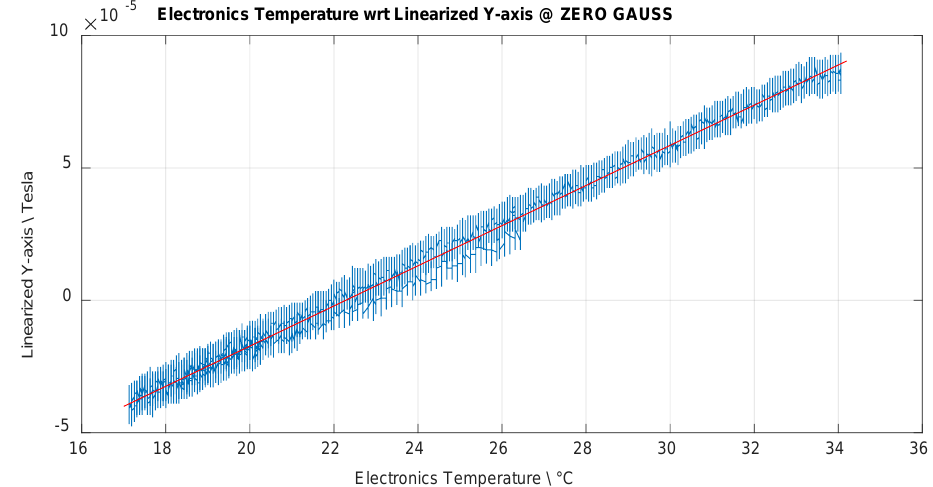
Figure 18. Graph showing the variation of the instrument output when the Hall probe is at zero gauss and at ambient reference temperature while the electronics temperature is varied from 17 °C up to 34 °C. This additional offset is compensated for using a 1st order polynomial fit.